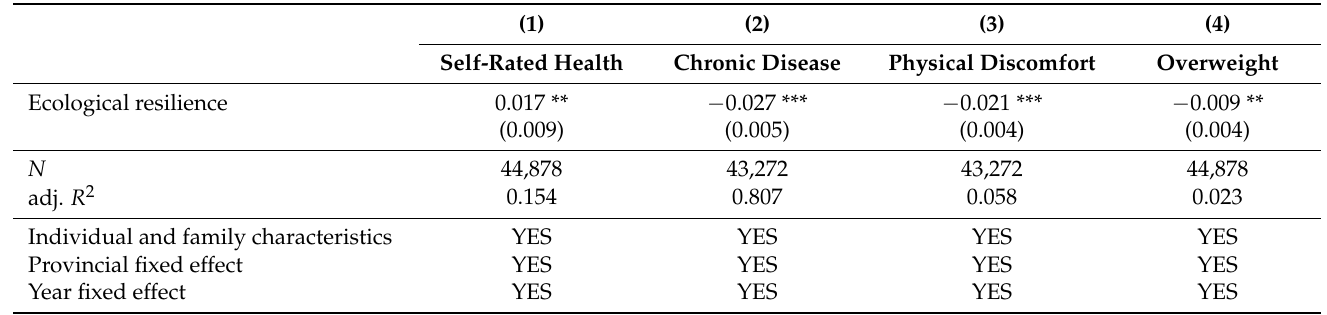
Table 10. The improvement of personal